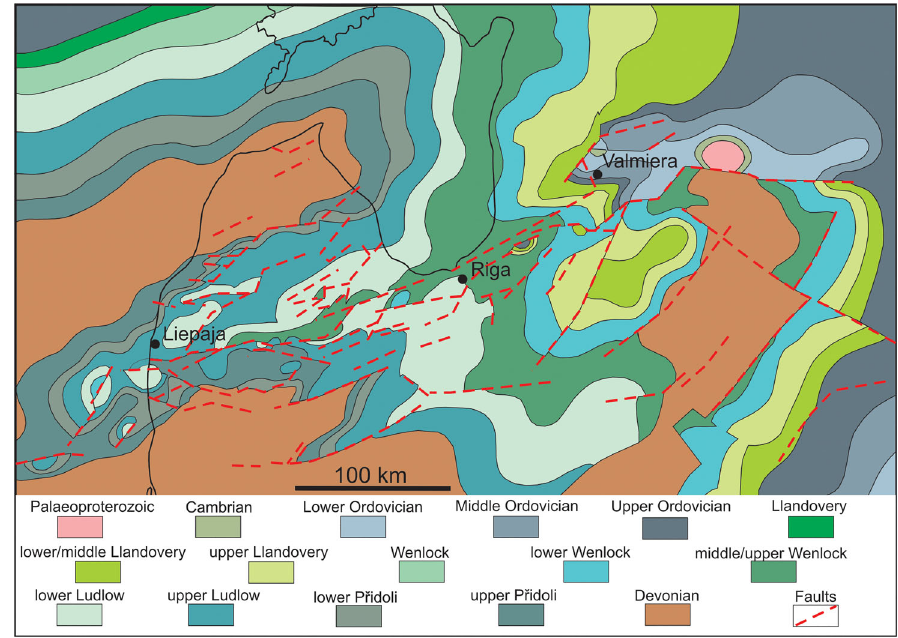
Fig. 15. Subcrop map revealing the extent of erosion below the lowermost Devonian unconformity around the LeRPFZ onshore section (modified after Polivko